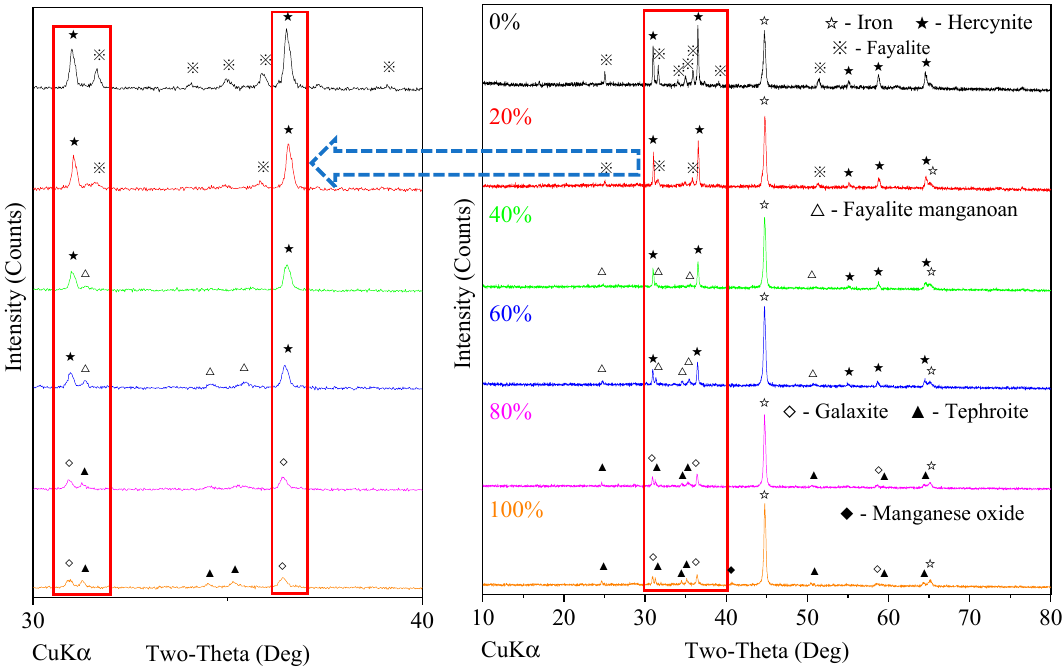
Figure 12. XRD patterns of reduced pellets with different ratio of high-maganese iron ore (HM ore) (reducing at 1050 °C for 90 min with C/Fe mass ratio of 1.5).